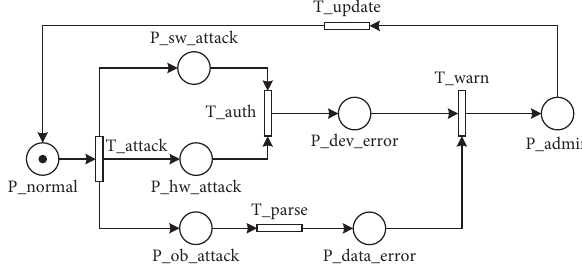
Figure 4: SPN model of the